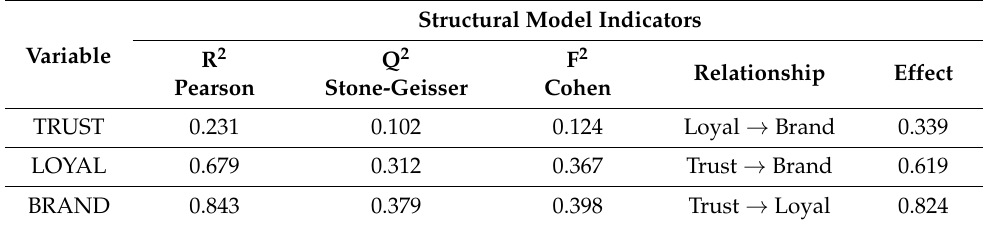
Table 4. Structural model